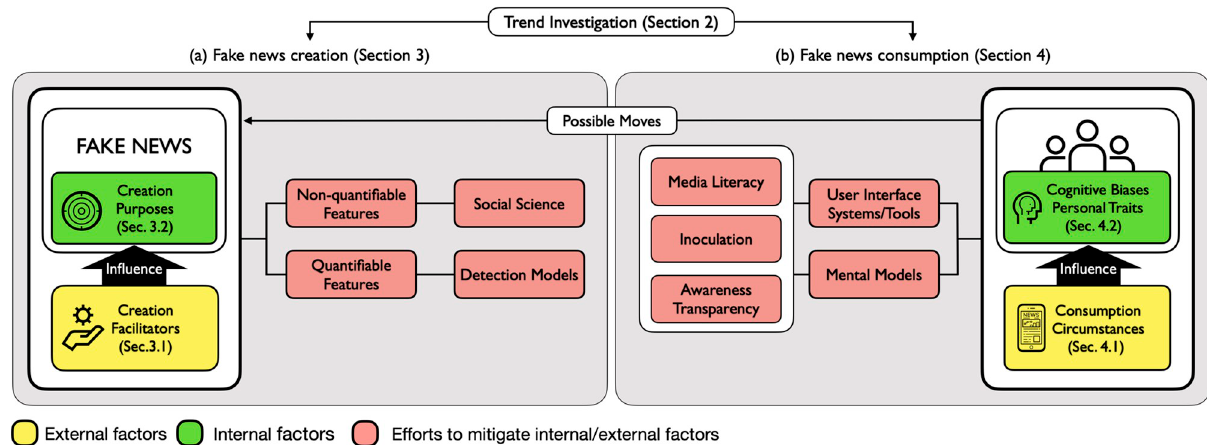
Fig 3. An overview of the survey on fake news research in this paper. We investigate fake news research trend (Section 2), and examine fake news creation and consumption through the lenses of external and internal factors. We also investigate research efforts to mitigate external factors of fake news creation and consumption: (a) indicates fake news creation (Section 3), and (b) indicates fake news consumption (Section 4). “Possible moves” indicates that news consumers “possibly” create/propagate fake news without being aware of any negative impact.